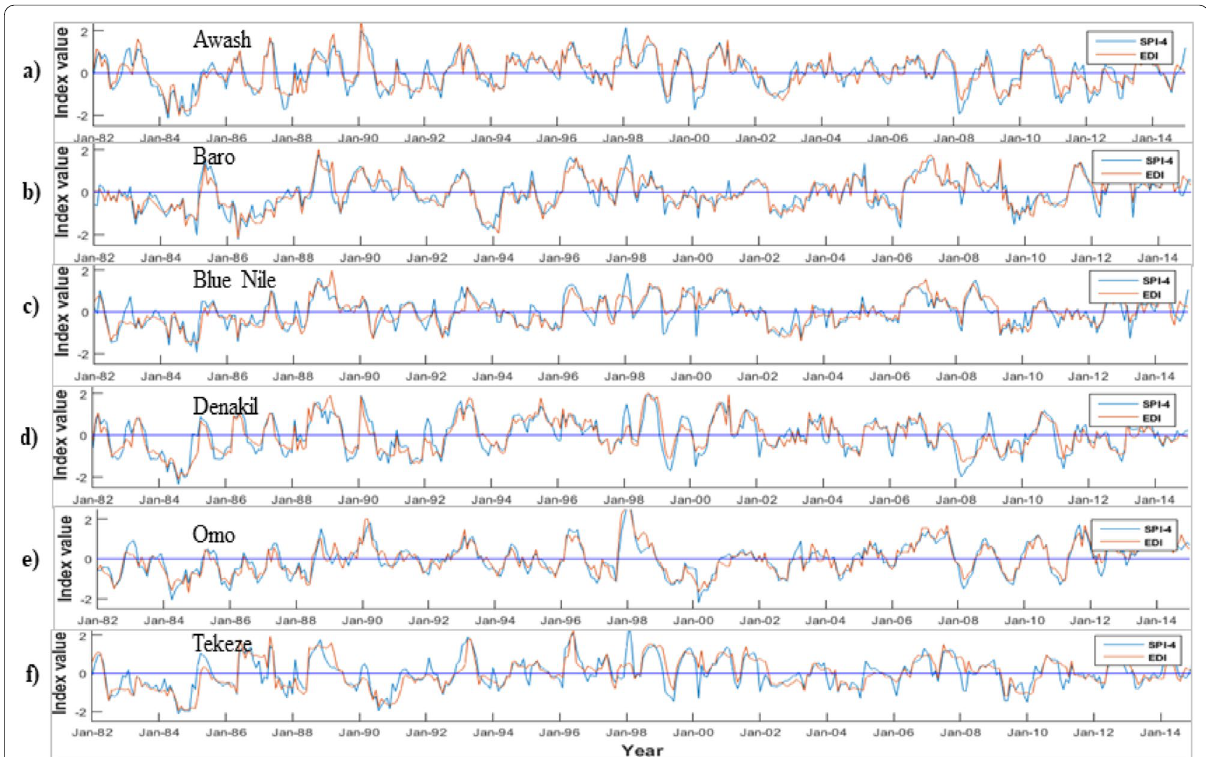
Fig. 10 Temporal trends of monthly EDI and SPI-4 identified drought across the main river basins of Ethiopia a ) Awash b ) Baro c ) Blue Nile d ) Denakil e ) Omo f )